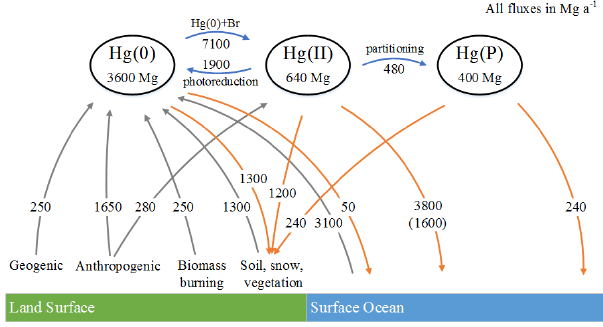
Figure 5. Global budget of atmospheric mercury derived from this study. The fluxes in parentheses indicate uptake of Hg(II) by sea- salt